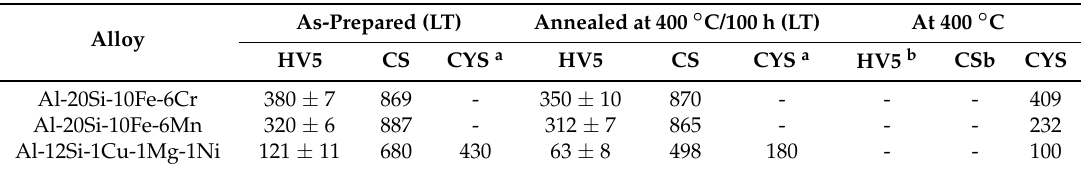
Table 3. Mechanical properties of the investigated MA + SPS alloys at laboratory temperature (LT) and at 400 ◦ C (HV5, Vickers hardness; CS, compressive strength in MPa; CYS, compressive yield strength in MPa). ( a The CYS could not be determined for the MA + SPS alloys; b The HV5 and CS could not be determined during test at 400 ◦